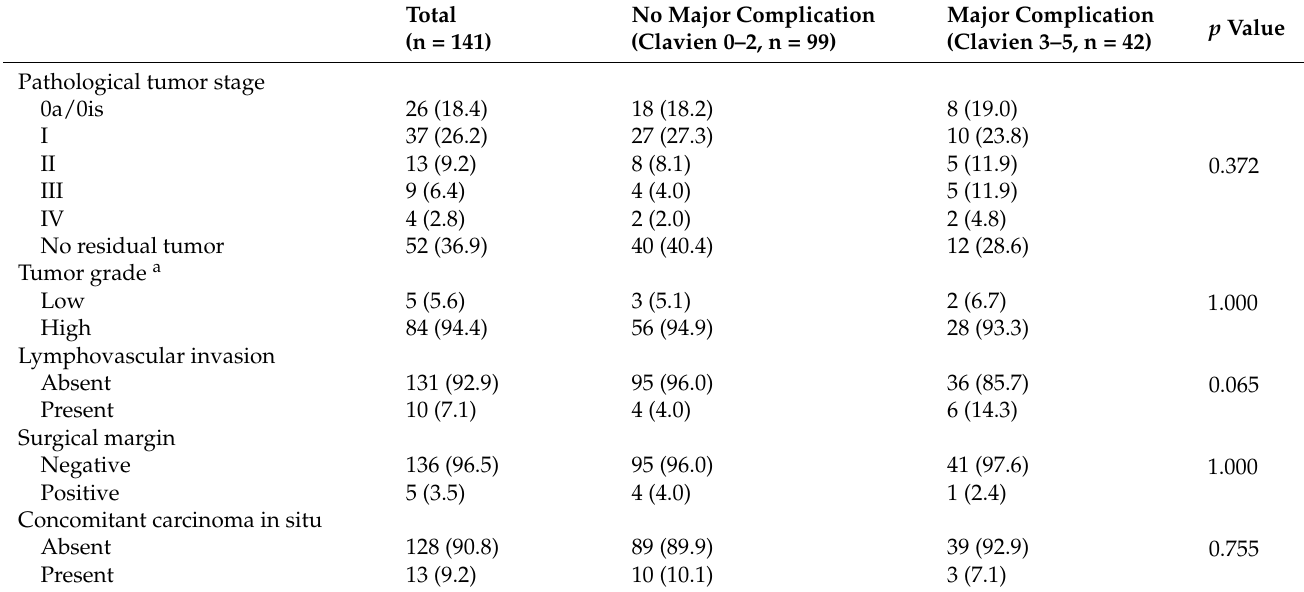
Table 2. Pathological features of dialysis patients undergoing radical